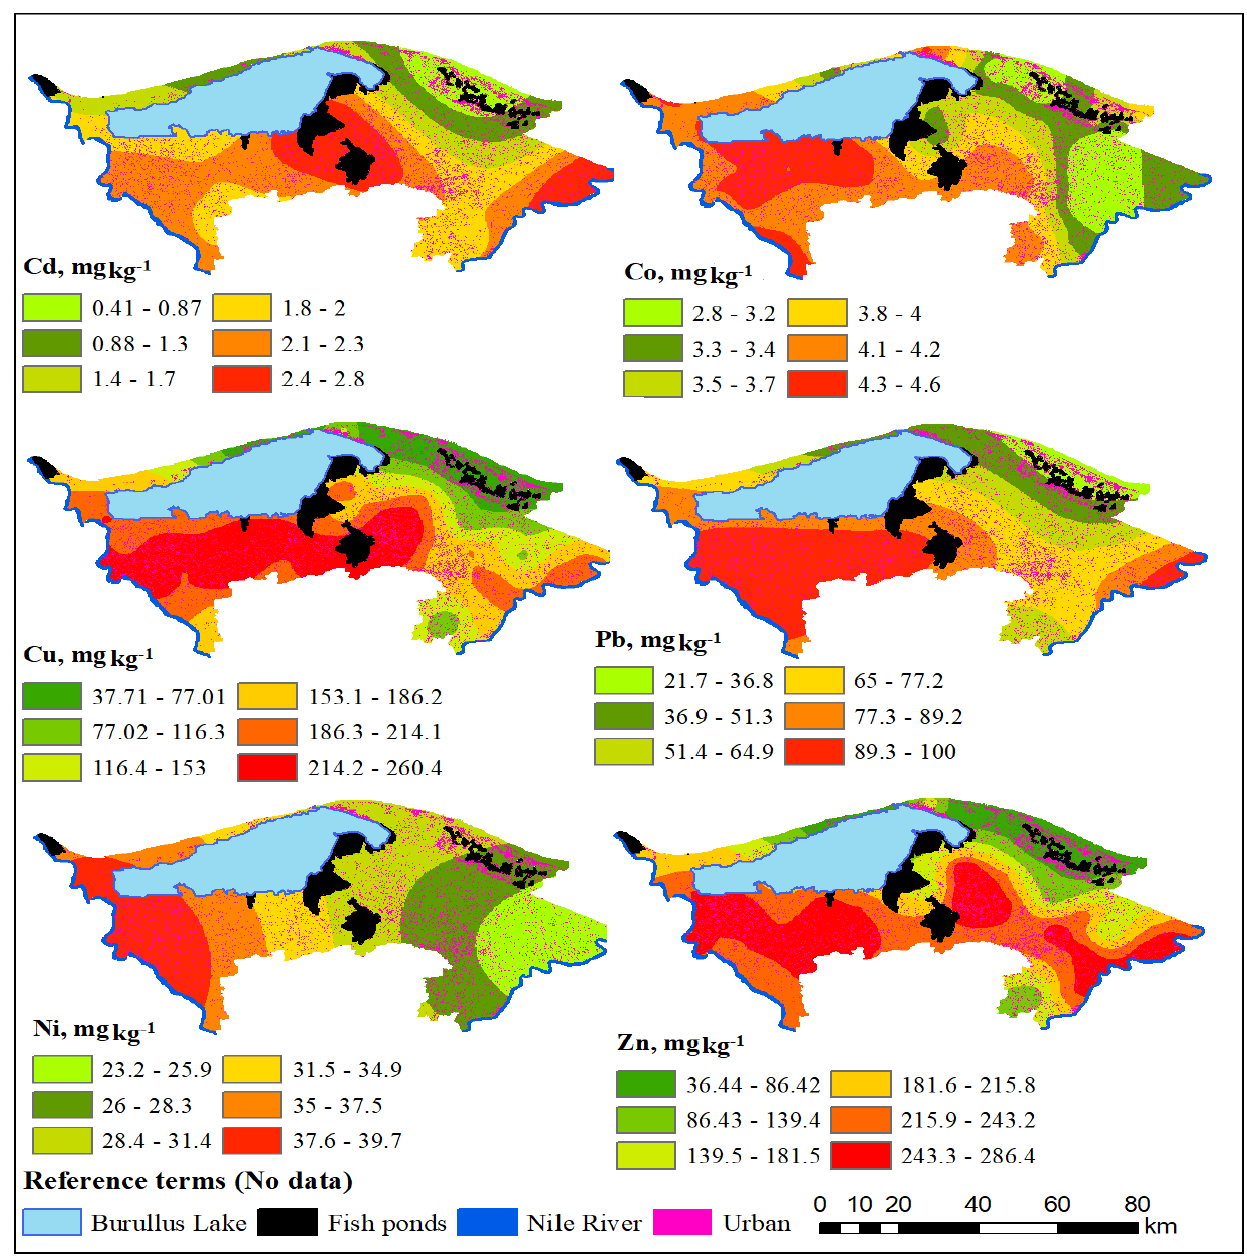
Figure 3. Spatial distribution maps of the studied elements based on the weighted mean value of soil profiles.